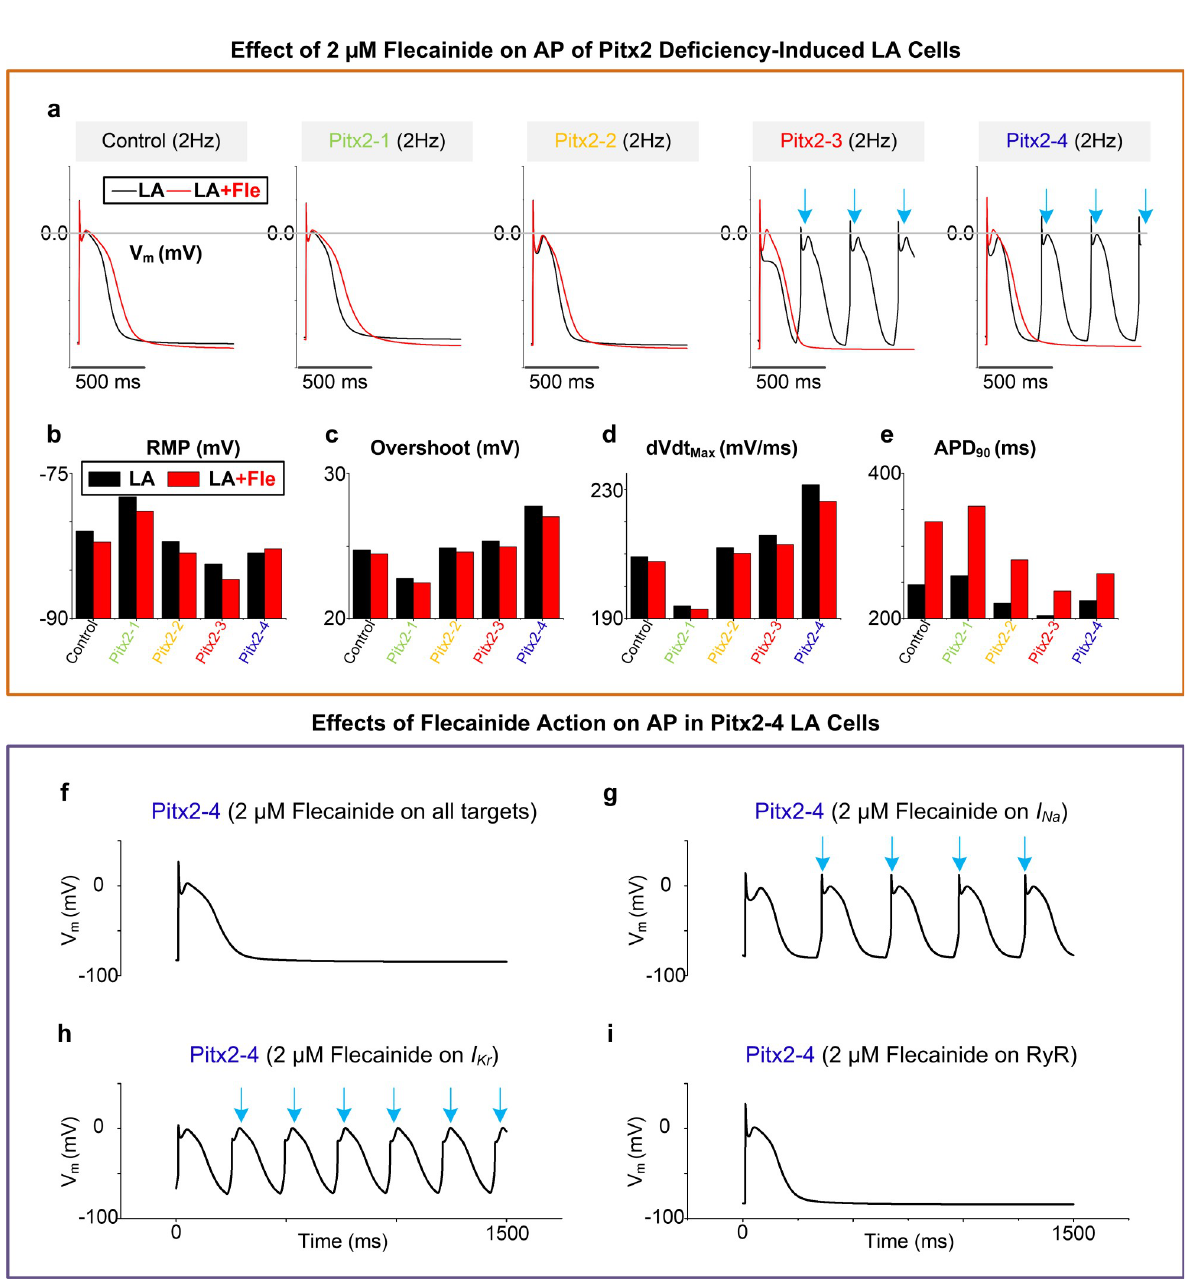
Fig 3. Antiarrhythmic effects of flecainide on action potentials (AP, V m ). a , Comparison of APs of LA cells in the presence or absence of 2 μ M Fle. The main AP parameters included RMP ( b ), overshoot ( c ), dVdtmax ( d ) and APD ( e ). Simulated effects of 2 μ M Fle on all targets ( f ), and on I Na ( g ), on I kr ( h ) and on RyR ( i ) respectively. Blue arrows indicate delayed afterdepolarizations. Abbreviations: LA–left atrium; Fle–flecainide; RMP–resting membrane potential; dVdt max − maximum upstroke velocity; APD–action potential duration; RyR–ryanodine receptor.